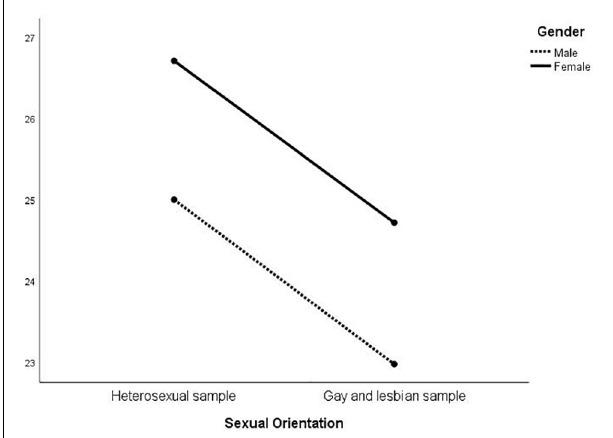
FIGURE 4 | Interaction of gender × sexual orientation on EIQ F4-Variety of partners.